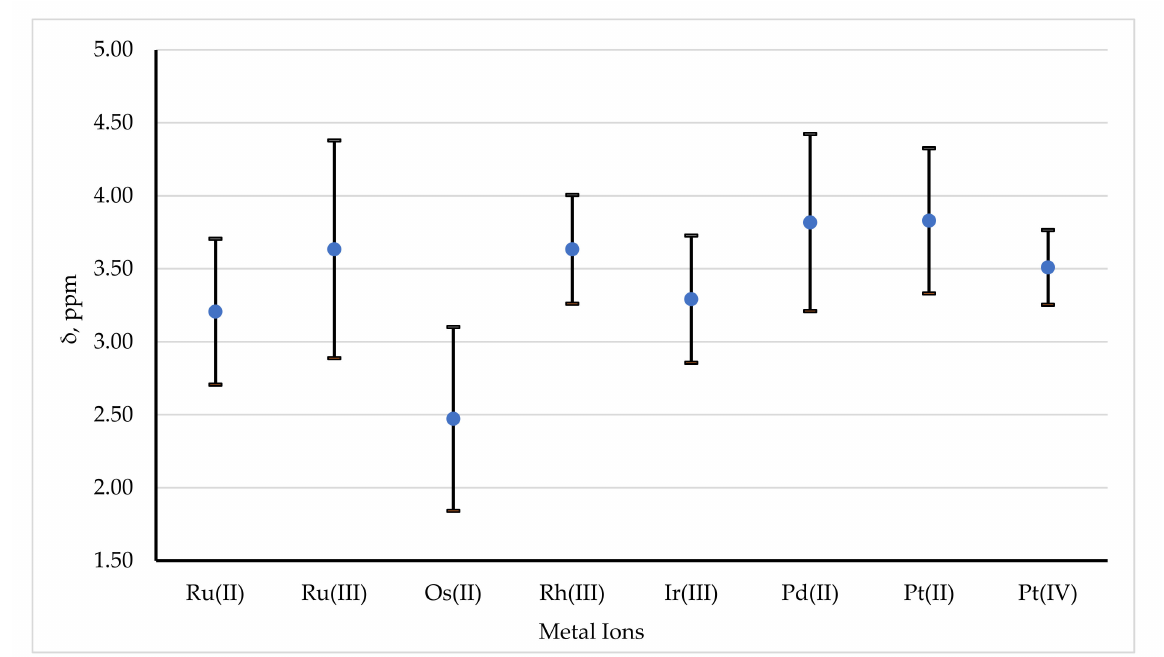
Figure 15. The mean and 95% range (two standard deviations) for the 1 H chemical shifts reported for α -hydrogen